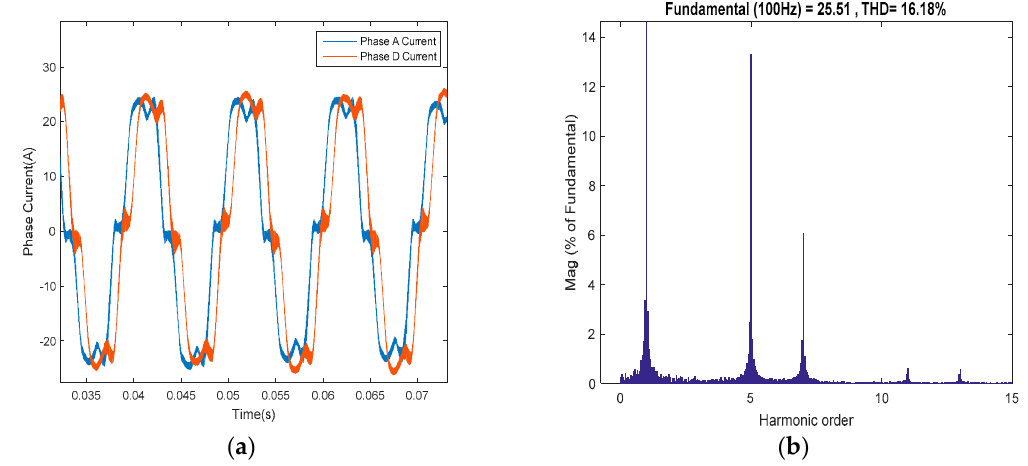
Figure 14. Experimental results without adopting the ADALINE-based voltage compensator when the motor speed is 1500 rpm, ( a ) Phase A and D currents and ( b ) THD for phase A current.